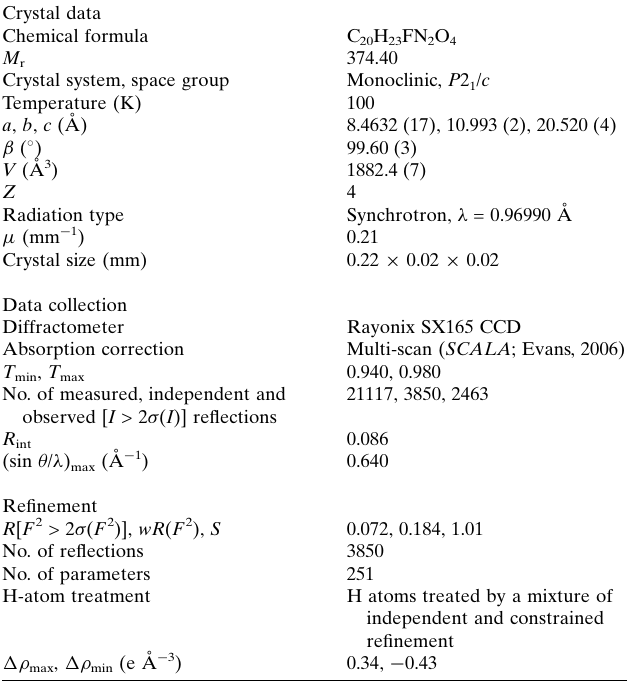
Table 2 Experimental details. Crystal data Chemical formula